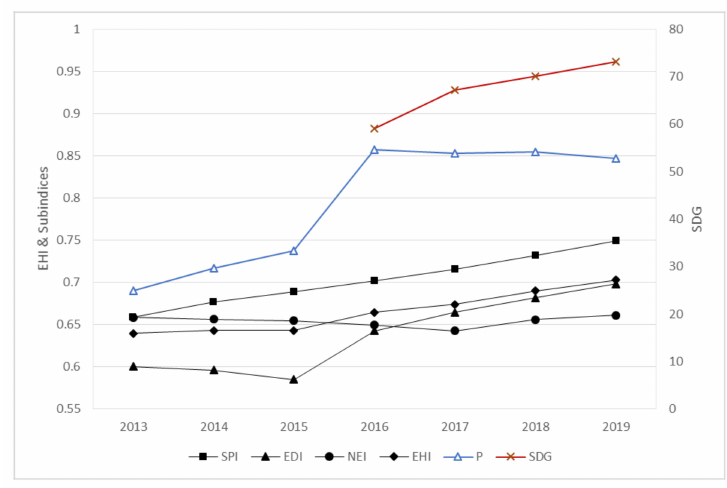
Figure 3. Trends in China’s ecosystem health index and subindexes, 2013–2019.